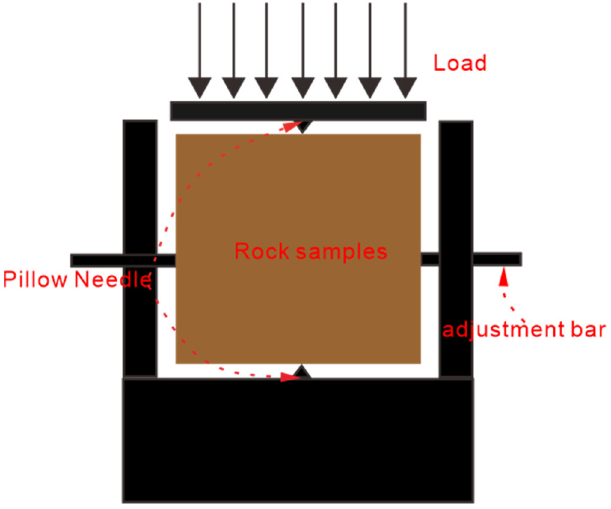
Figure 5. Schematic diagram of spliing device.